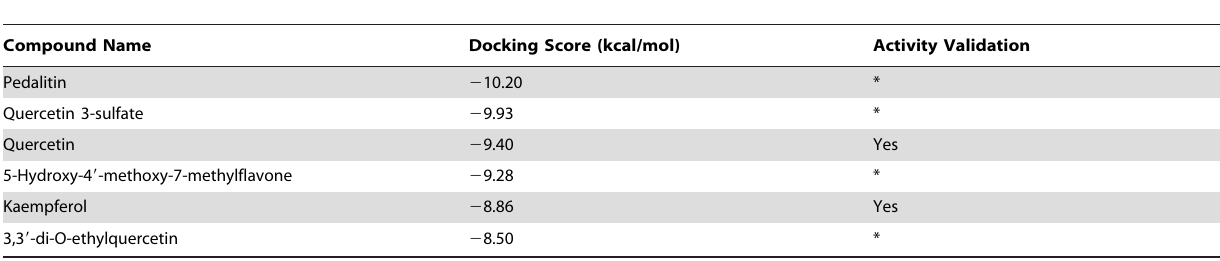
Table 1. Results of virtual screening for RSK2